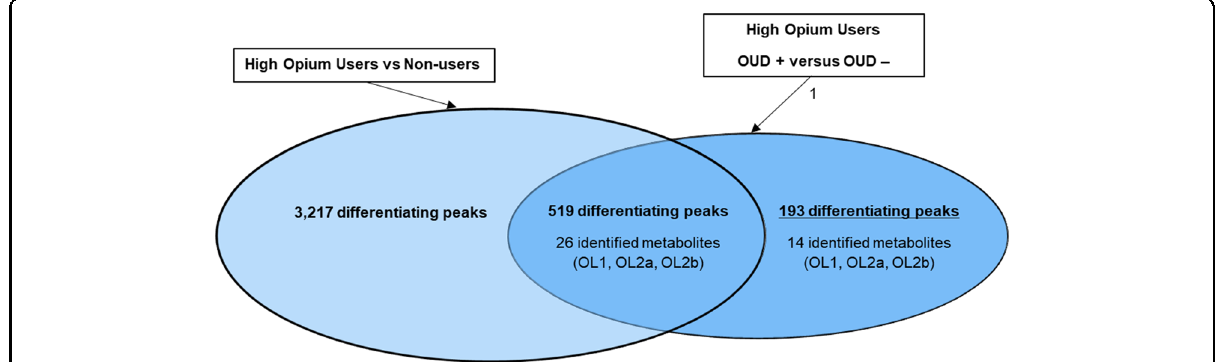
Fig. 1 Over 3700 peaks differentiated high opium users from non-opium users. 712 peaks differentiated high opium users diagnosed as OUD positive from high opium users diagnosed as OUD negative. 193 peaks were unique to the differentiation OUD positive versus OUD negative high opium users. Metabolites were identi fi ed or annotated using an in-house physical standards library, and peaks were annotated using big data